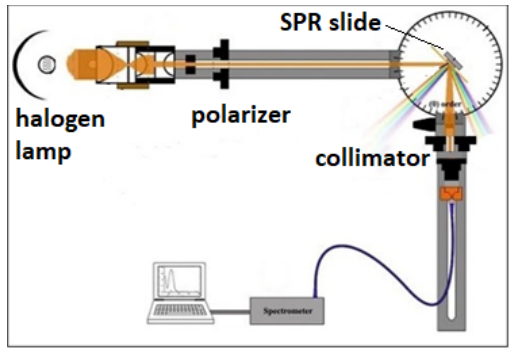
Figure 1. Optical setup for the SPR measurements.